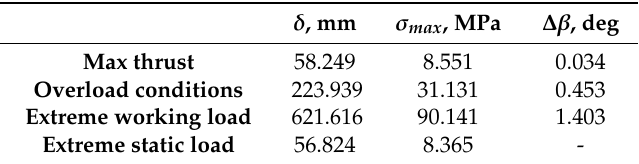
Table 6. Tip deflection, maximal equivalent stresses, and deformation twist for all considered cases (mesh